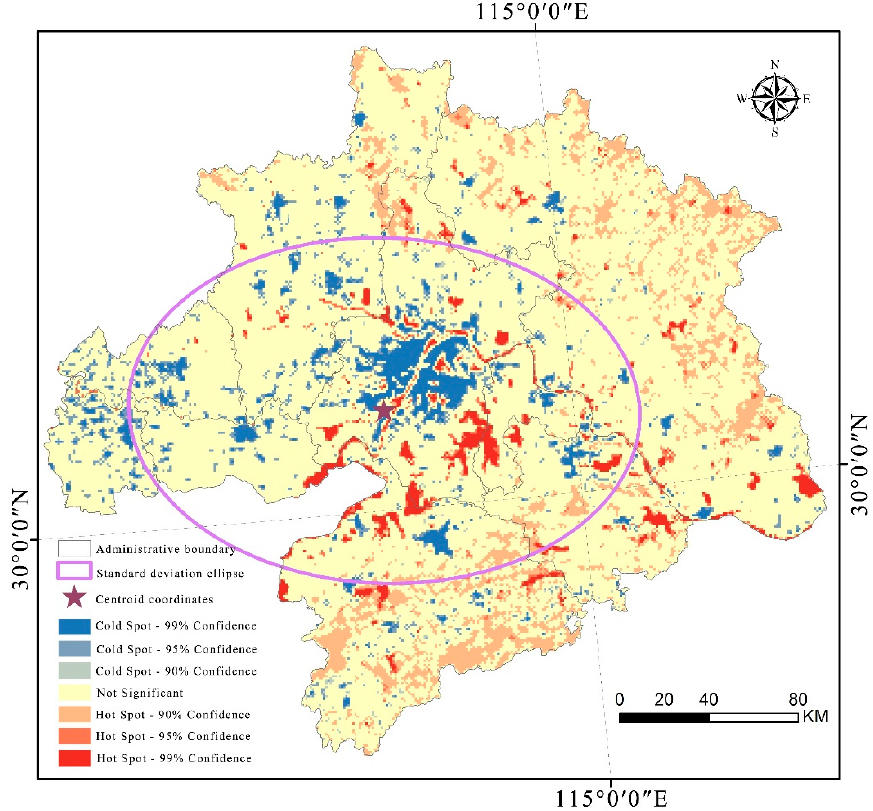
Figure 6. Standard deviation ellipse and local spatial autocorrelation analysis in the study area.